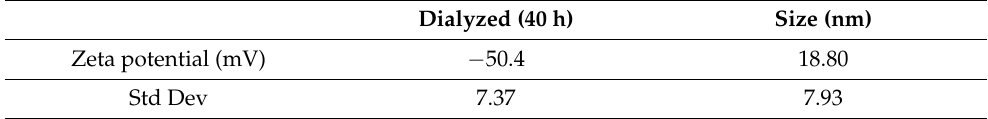
Table 2. Zeta potential measurements with size and their standard deviations.